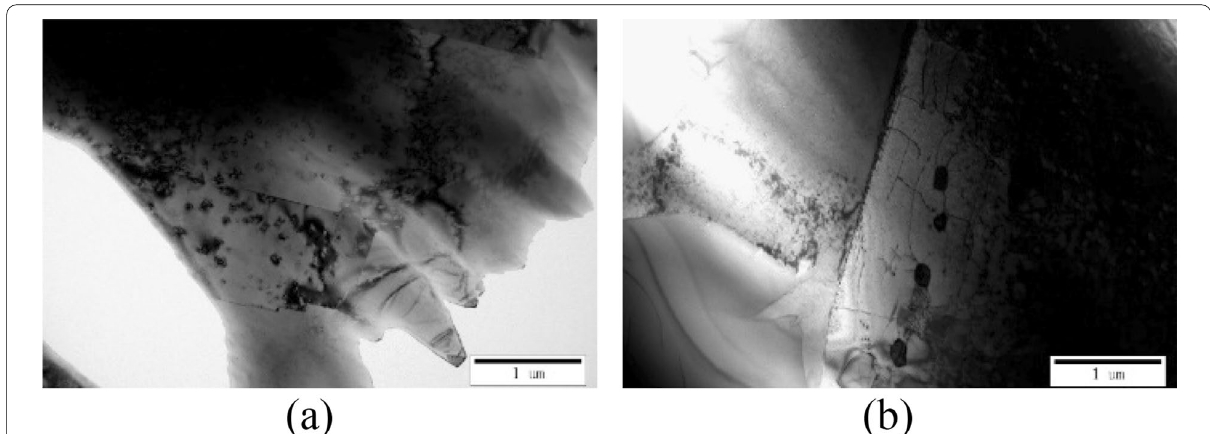
Figure 8 TEM image of the CuMn 13 Al 7 sample formed by wire arc additive manufacturing: a particles